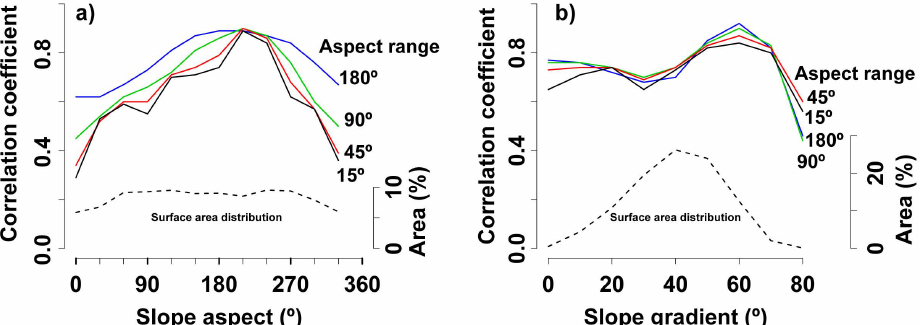
Fig. 6. Correlation coefficients between the debris-covered area and potential debris-supply (PDS) slope area, plotted against (a) aspect (clockwise from north), and (b) gradient of the PDS slope. Correlation coefficients were calculated over four sampling aspect ranges (180 ◦ , 90 ◦ , 45 ◦ , and 15 ◦ ). Surface area distributions are calculated in (a) aspect bin of 30 ◦ , and (b) gradient bin of 10 ◦ . The central aspect is fixed to the southwest (225 ◦ ) in (b) , at which the highest correlation coefficient was found in (a) .